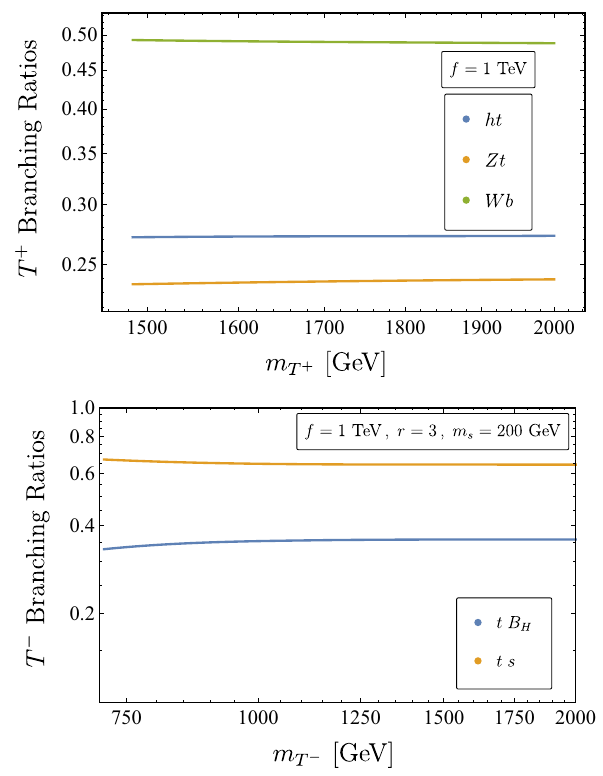
Fig. 1 Left panel : Numeric results for branching ratios of T + for f = 1 TeV. Right Panel: Numeric results for branching ratios of T − for f = 1 TeV, r = 3 and m s = 200 GeV. The mass of B H is a function = 270 of f , r , in this case m B H